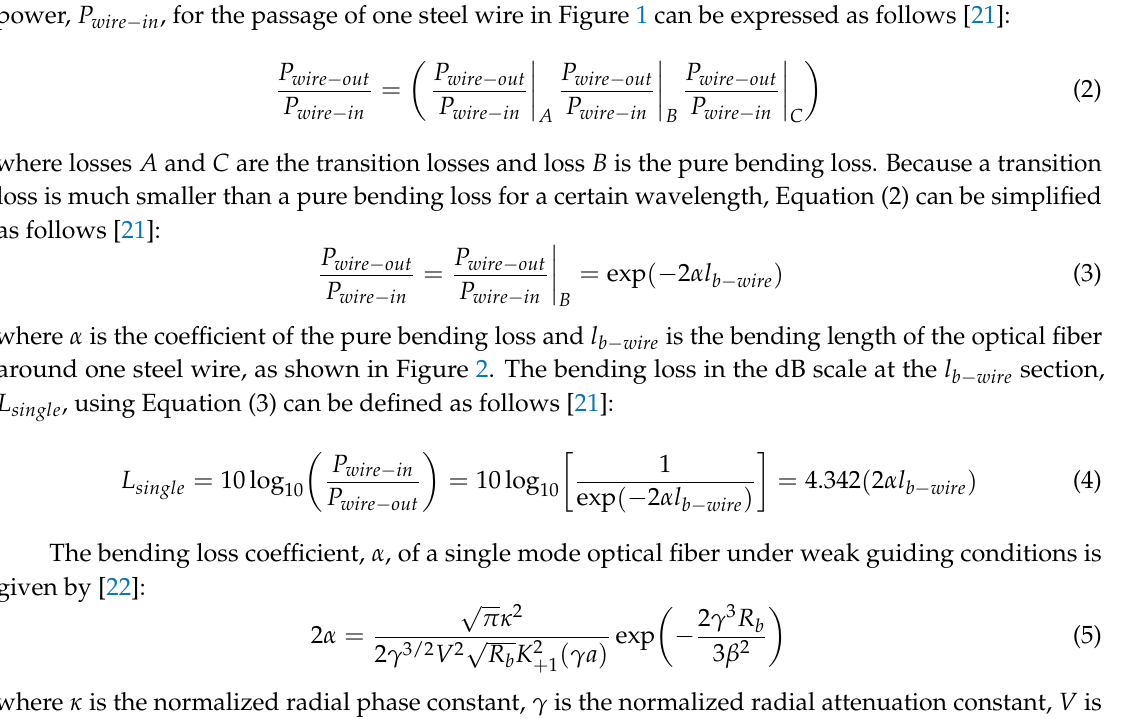
Figure 2. Schematic of the twisted dual-cycle bending length 𝑙 (cid:3029)(cid:2879)(cid:3050)(cid:3036)(cid:3045)(cid:3032) .